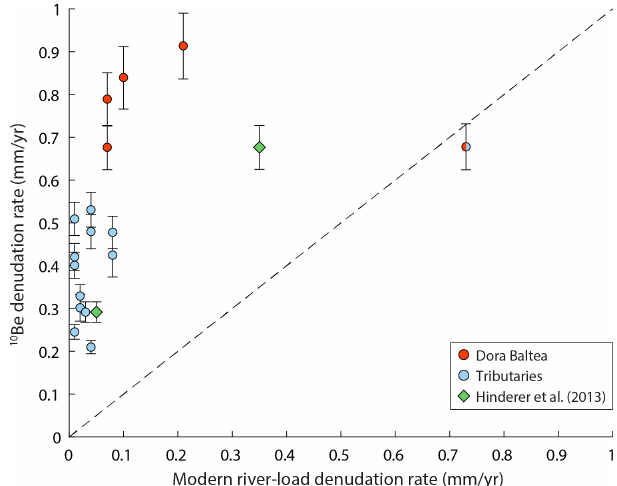
Figure 8. Comparison of 10 Be- and modern river yield-derived catchment-wide denudation rates. For all tributary catchments and DB locations, modern denudation rates are derived from river– bedload empirical estimates (Vezzoli et al., 2004; red and light blue dots are for DB and tributary catchments, respectively). For catch- ments DB06 and DB011, also modern denudation rates derived re- spectively from sediment gauging and sediment trapping are plotted with green diamonds (Hinderer et al., 2013, after Bartolini et al., 1996, and Bartolini and Fontanelli, 2009). Errors are represented only for 10 Be-derived denudation rates, since they are not reported for the modern